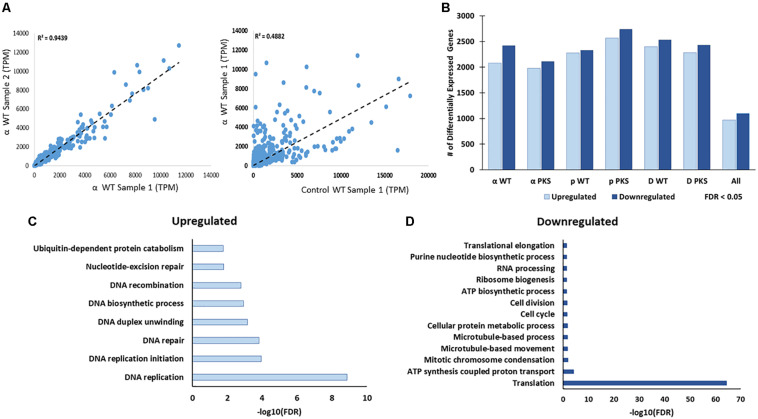
(A) Correlation between Transcripts Per Million (TPM) counts between biological replicate samples within the same condition, between different strains in the same condition, or within the same strain across different conditions. Here, and below, the strains included are the melanized WT and the non-melanized PKS strains, and the condition being exposure to the second-highest dose of particle IR, as detailed in the Section “Materials and Methods” (250 Gy α-particles, 840 Gy protons, and 500 Gy deuterons). (B) The number of genes differentially expressed, with a significance cutoff of FDR < 0.05, for each condition, as well as shared in all conditions. (C) Gene Ontology-Biological Process categories enriched with the shared, upregulated and (D) downregulated gene sets. FDR values provided by FungiFun 2.0. Higher absolute values of –log10(FDR) demonstrate greater significance.